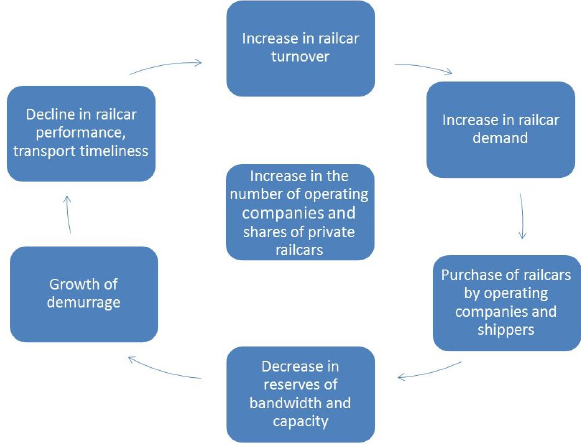
Figure 1: Principal causes of timeliness reduction of freight railway transportation in Russian railway transportation market.